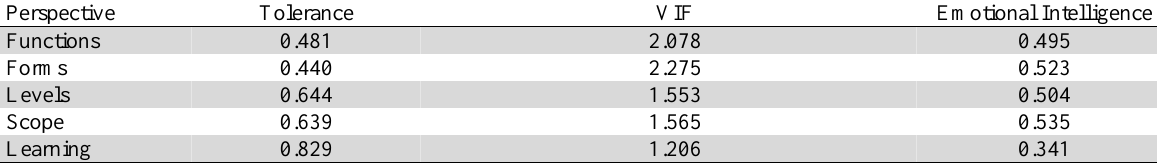
The summary of testing colinearity as well as Pearson correlation test Perspective